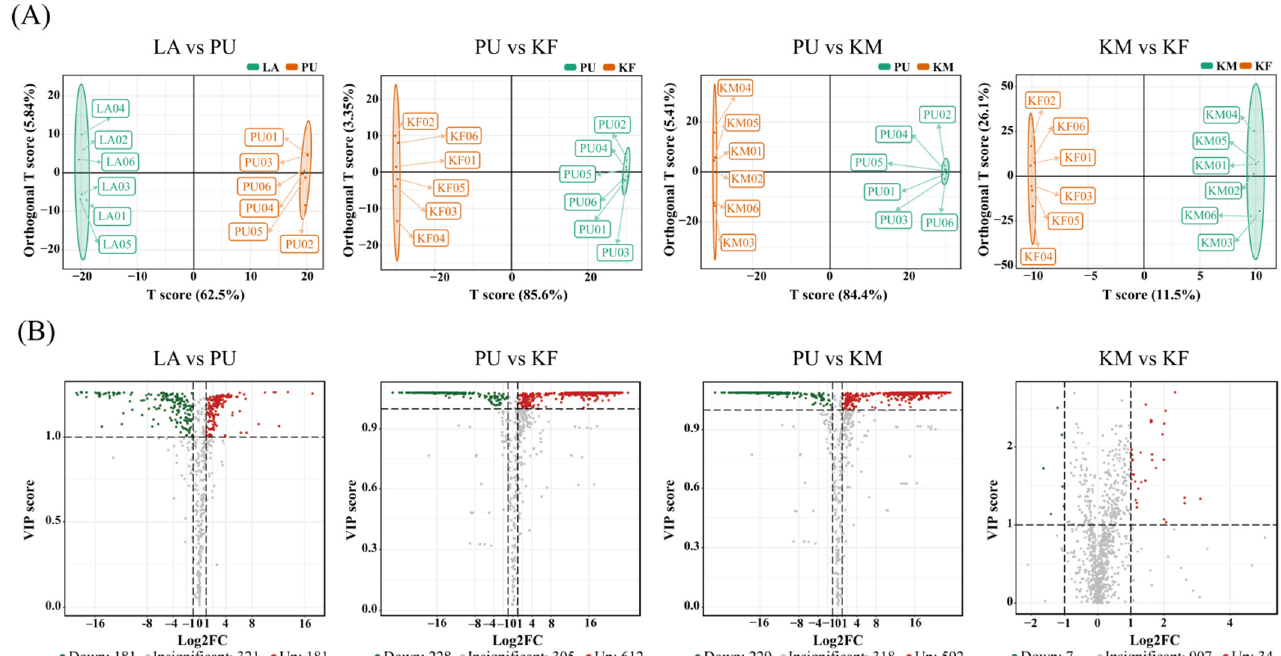
Figure 2. Identification of the differential accumulated metabolites (DAMs) in different comparison groups (LA vs PU, PU vs. KF, PU vs. KM, KM vs. KF). ( A ) OPLS-DA (partial least squares discriminant analysis) score plots of four comparison groups. The x and y axes represent score for the main components in orthogonal signal correction (OSC) process (Tp) and score for the orthogonal components in OSC process (To), respectively. The abscissa and ordinate coordinates can show differences between and within groups, respectively. The percentage (%) represents the resolution of component to dataset. ( B ) The distribution of DAMs identified by the cut-off value of VIP ≥ 1 and absolute Log 2 FC ≥ 1. The green bubbles represent the significantly decreased DAMs while the red bubbles represent the significantly increased DAMs. The VIP score generated in OPLS-DA processing represented the contribution to the discrimination of each metabolite ion between groups.